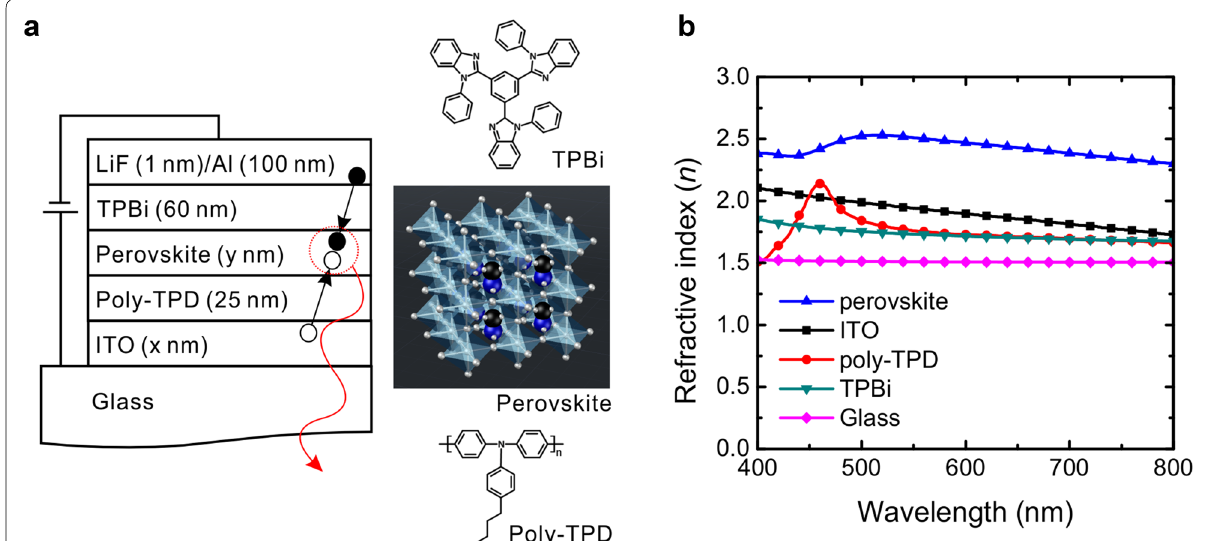
Fig. 1 a Structure of the perovskite LED with a multi‑layered structure for optical simulations. The molecular structures of the hole‑transporting layer (poly‑TPD), electron‑transporting layer (TPBi), and emitting layer (perovskite) are included. b Refractive indexes of the layers in the perovskite LED as a function of